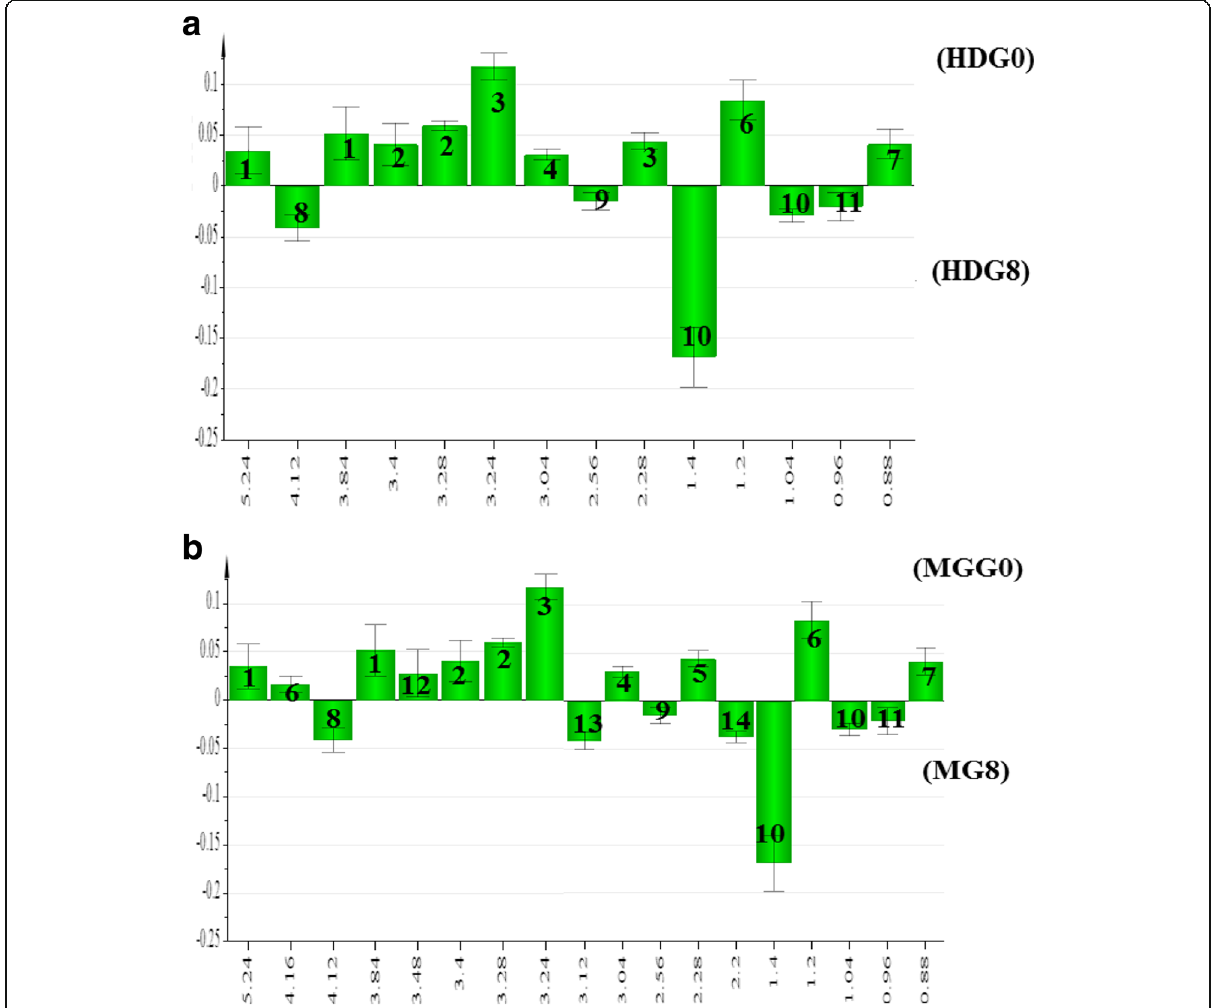
Fig. 10 OPLS-DA loading column plot of ( a ) ML and ( b ) metformin obtained using 1 H NMR data for serum samples from Sprague-Dawley rats, Week0 (HDG0), and Week8 (HDFG8). For ML: 1; α -glucose, 2; taurine, 3; choline, 4; creatine, 5; acetoacetate, 6; 3-hydroxybutyrate, 7; 2- hydroxybutyrate, 8; lactate, 9; citrate, 10; Isoleucine,11; leucine. For metformin; 1; α -glucose, 2; taurine, 3; choline, 4; creatine, 5; acetoacetate, 6; 3- hydroxybutyrate, 7; 2-hydroxybutyrate, 8; lactate, 9; citrate, 10; Isoleucine,11; leucine, 12; β -glucose, 13; creatinine, 14;